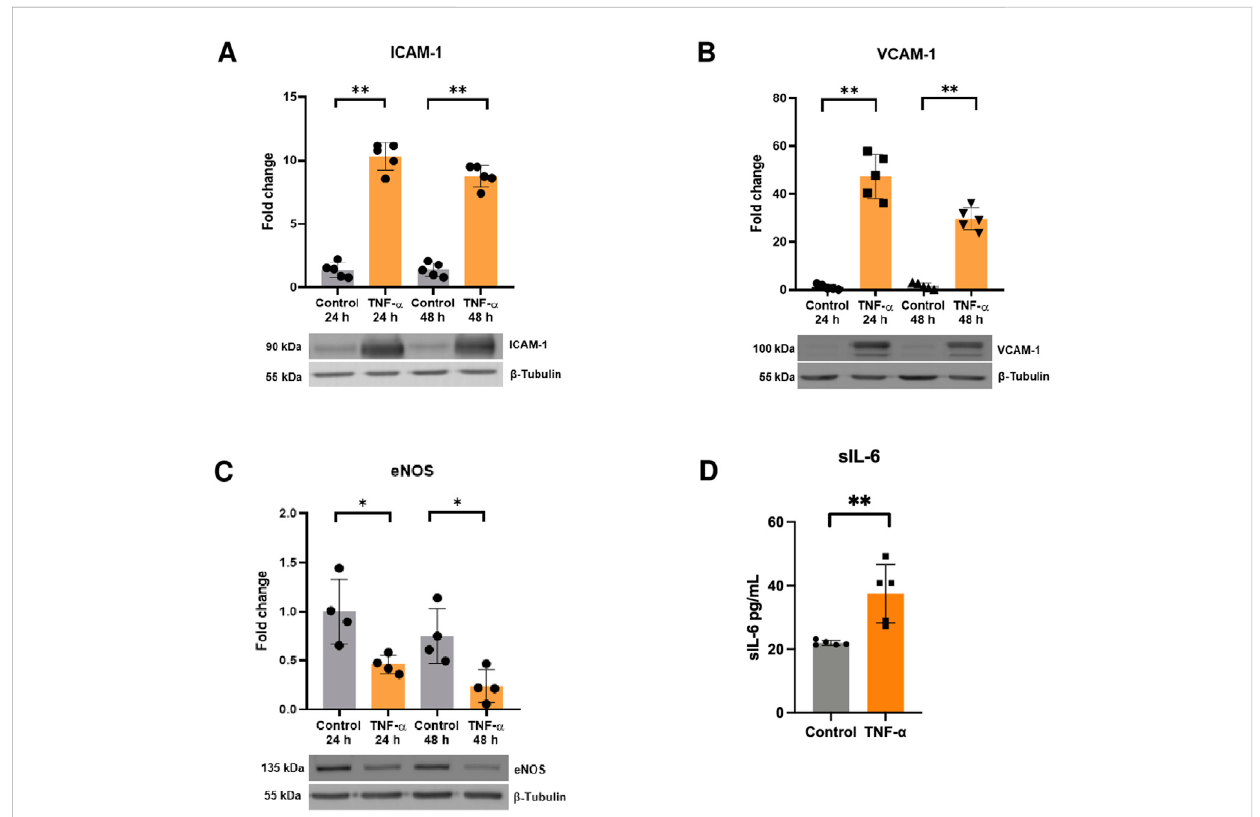
FIGURE 1 TNF- α induces endothelial activation. Protein levels of (A) ICAM-1 (n = 5), (B) VCAM-1 (n = 5), and (C) eNOS in response to TNF- α 10 mg/mL for 24 h and 48 h determined by Western blot (n = 4). (D) sIL-6 levels were assessed by ELISA after administration of TNF- α for 24 h (n = 5). * p < 0.05, ** p < 0.01 vs. 24 h control, 48-h control, or control. Mean ±